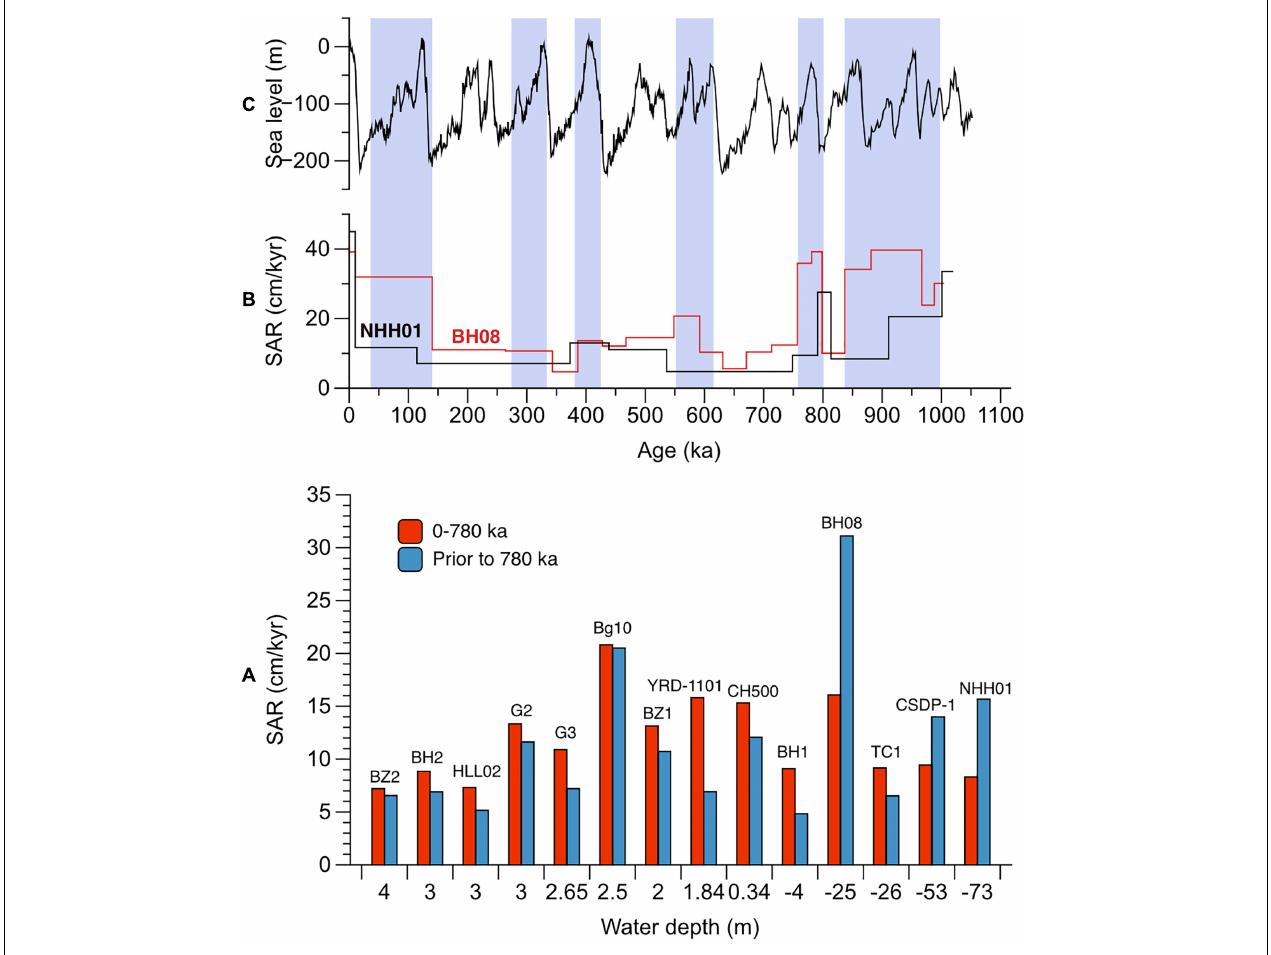
FIGURE 6 | Sedimentary accumulation rates (SAR) at the tectonic (A) and orbital (B) timescale for cores from the Bohai Sea, Yellow Sea, and coastal plain, and comparison with the global sea-level curve ( C ; Miller et al., 2005). Data for core BZ2 are from Yao et al. (2010, 2012), BH1, BH2, and HLL02 from Yi et al. (2016). Lz908 from Yi et al. (2015), NHH01 from Liu et al. (2014), CSDP-1 from Liu S. et al. (2016), Liu et al. (2018); BZ1 from Xiao et al. (2008), TJC-1 from Li et al. (2016) YRD-1101 from Liu et al. (2020), CH500 from Pei et al. (2016), Bg10 from Yuan et al. (2014), G2 from Xiao et al. (2014), G3 from Yang et al. (2020).